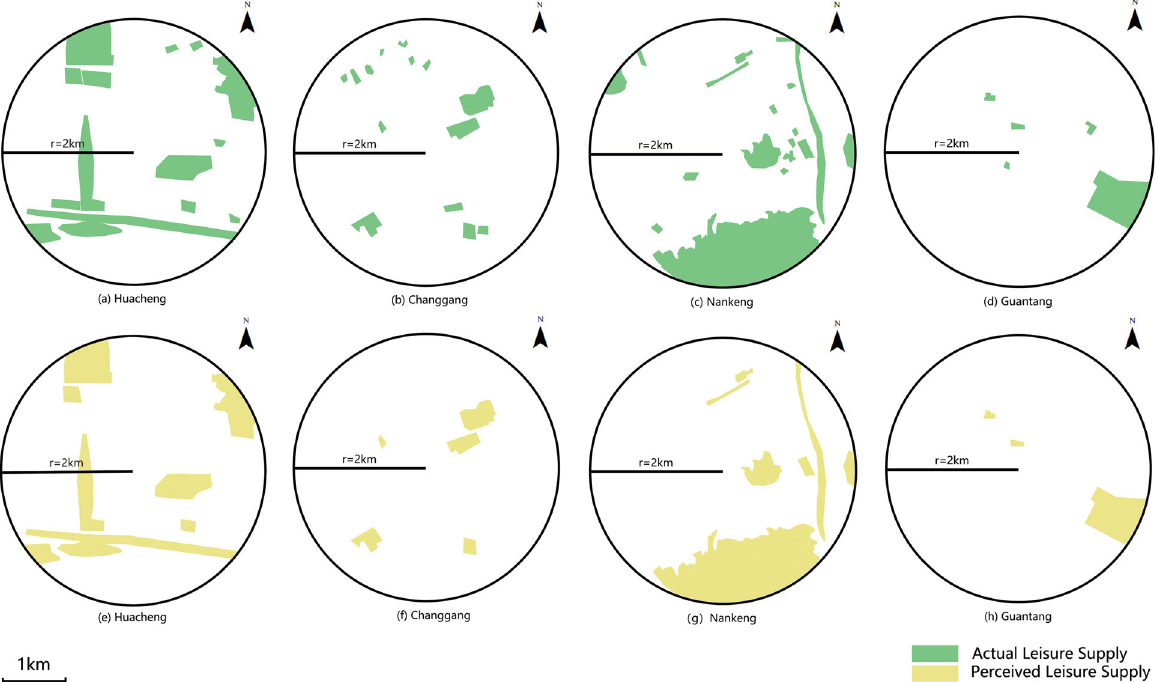
Fig. 3 The results of comparison between actual and perceived leisure supply by communities. Pictures a – d present theactual leisure supply of each community. Pictures e – h present the perceived supply of each